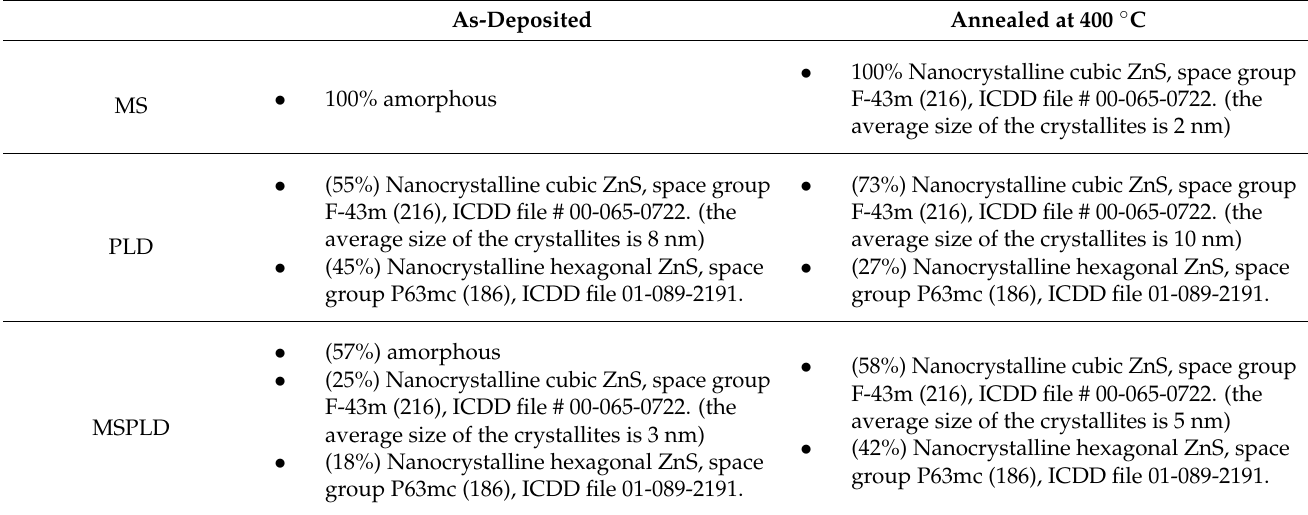
Table 2. The crystalline phases in the three types of ZnS thin films. The average size of the crystallites was approximated using Scherrer equation for the (111) c-ZnS